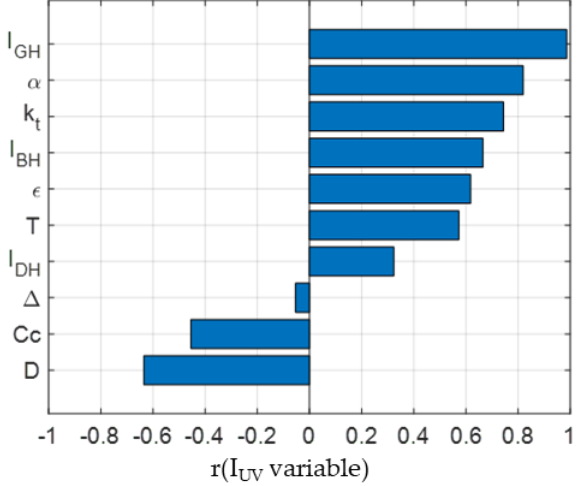
Figure 3. The Pearson correlation coefficient, r(I UV , variable), between I UV and the meteorological variables considered in the study.